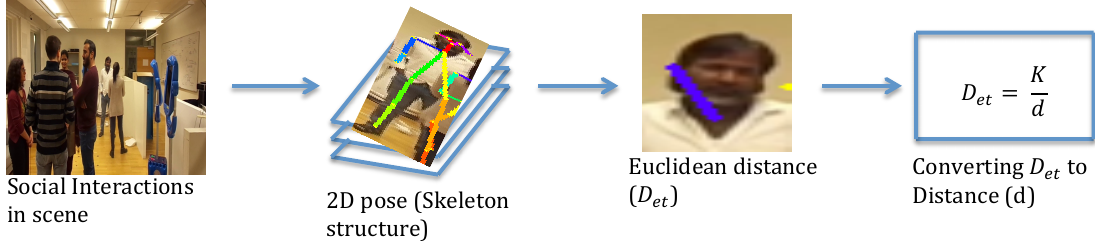
Figure 2. Overview of our method. First, an RGB image is used as input for our method. Second, the 2D pose (skeleton structure) for each person in the scene is obtained using the [25] approach. Third, the Euclidean distance D et between the Ear-torso points is calculated. Finally, real distance d is calculated by substituting D et value in Equation